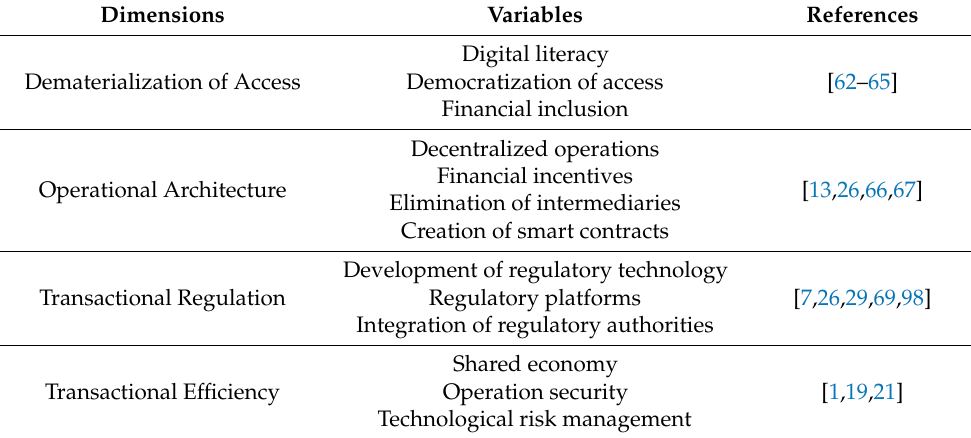
Table 4. Dimensions and variables of institutions and